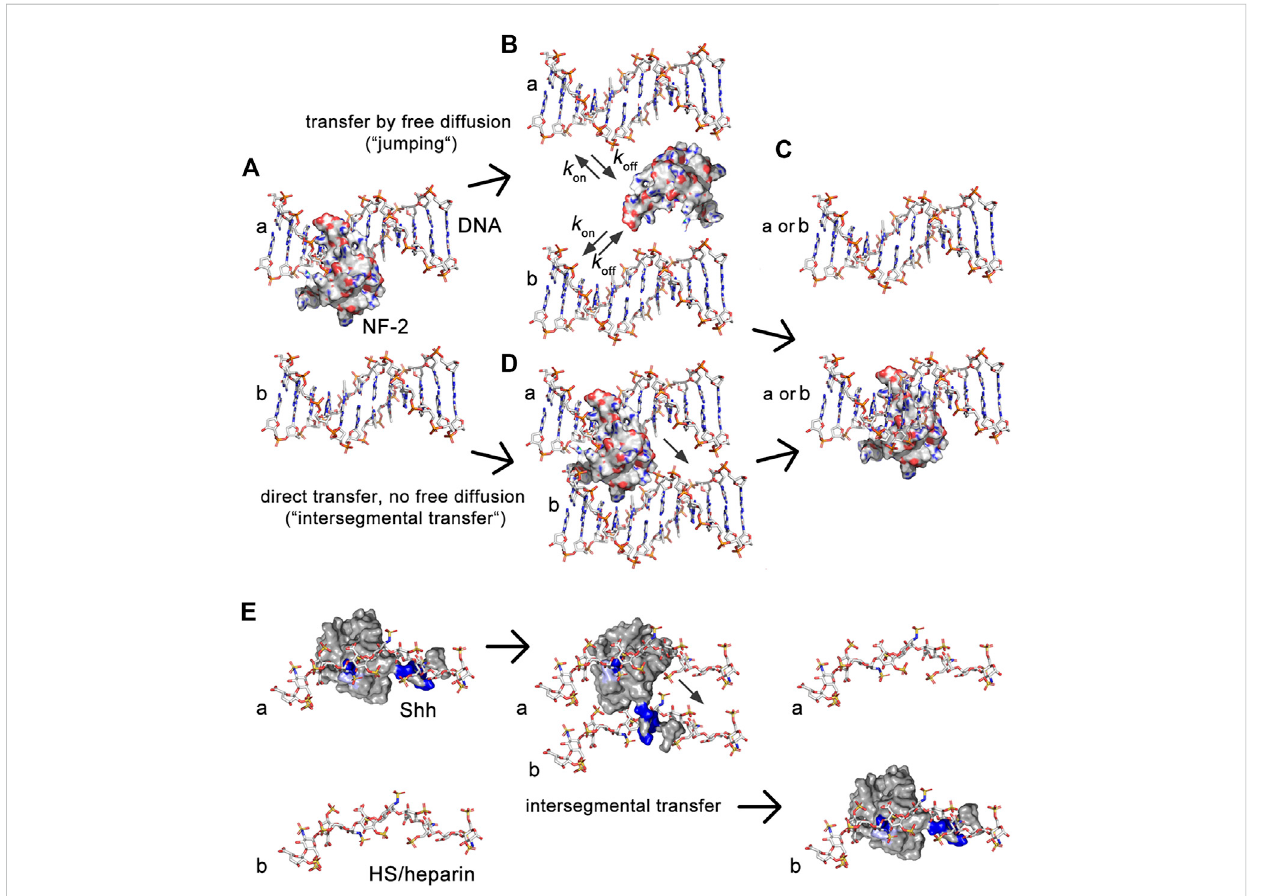
FIGURE 8 Illustration of the similarities between transport of intracellular DNA-binding proteins and extracellular HS-binding proteins. (A) DNA-binding proteins interact electrostatically with sugar-phosphate chains and exchange between them using two different mechanisms, called “ jumping ” and “ intersegmental transfer. ” Shown is the molecular structure of nuclear factor 2. (B) In the jumping mechanism, the protein fully dissociates from the fi rst DNAstrand (A) before binding to the second DNA strand [b in (C) ]or before re-binding to the fi rst (A) . (D) In theintersegmental transfer mechanism, two DNA-binding domains interact simultaneously with two DNA strands as a prerequisite to directly switch between them without a diffusible intermediary. (E) We recently showed that simultaneous Hh/Shh interactions with two extracellular sugar sulfate chains, as suggested by QCM-D, also serves as a prerequisite for intersegmental transfer (Gude et al., in press). Intersegmental transfer avoids intermittent free diffusion and subsequent Hh/ Shh loss into the overlaying fl uid- fi lled peripodial space. As a consequence, interference with HS-binding of the second site converts intersegmental transfer more into a jumping mode. Note that the fi rst interaction site of DNA binding proteins often locates to a fl exible tail, and that tailed DNA binders oftenswitchthroughanintermediateinwhichthesecondbindingsiteremainsabsorbedtooneDNAwhilethe fl exibletailsearchesfortheDNAacceptor (Vuzmanetal.,2010).This “ monkeybar ” mechanismavoidsintermittentstepsoffreeproteindiffusionandproteinlossfromDNA.Wenotethatthe fi rstHS binding site of Hh/Shh (the Cardin-Weintraub motif) also locates to an N-terminal extended protein tail. This suggests that a similar search-and-switch mechanismmaybeusedbytheHhs,andthatabortedswitchingofourmutatedproteinmayhaveconverteditintoafreelydiffusibleform.Shownarepdb structures 3iri (HS), 1bna (DNA), 1nk3 (nuclear factor 2) and 3 m1n (Shh). Structures are not to